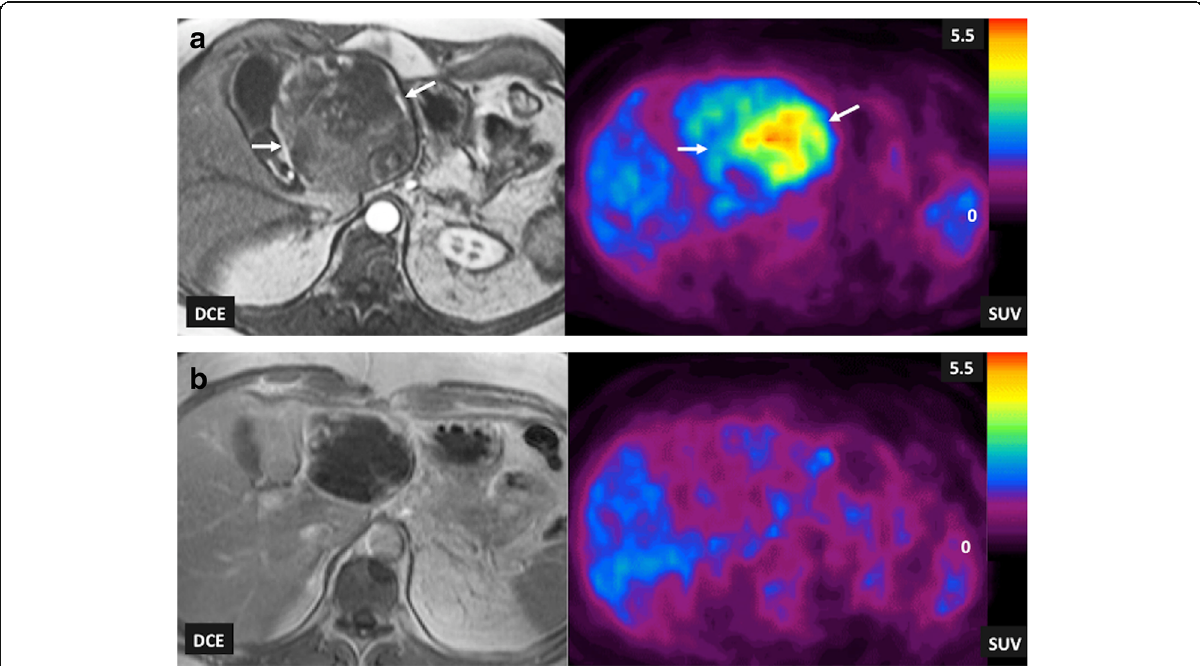
Fig. 13 Liver metastasis of a gastrointestinal stromal tumor (GIST) in a 68-year-old man. T1-weighted contrast-enhanced MRI (DCE) images and FDG-PET SUV parametric maps (SUV) acquired pretherapy ( a ) and following the administration of imatinib ( b ) and pretherapy ( a ), imaging findings evidenced a metabolic active tumor with areas of heterogenic enhancement (white arrows). Post-therapy ( b ), the tumor presented almost a total absence of enhancement and a complete metabolic response on PET